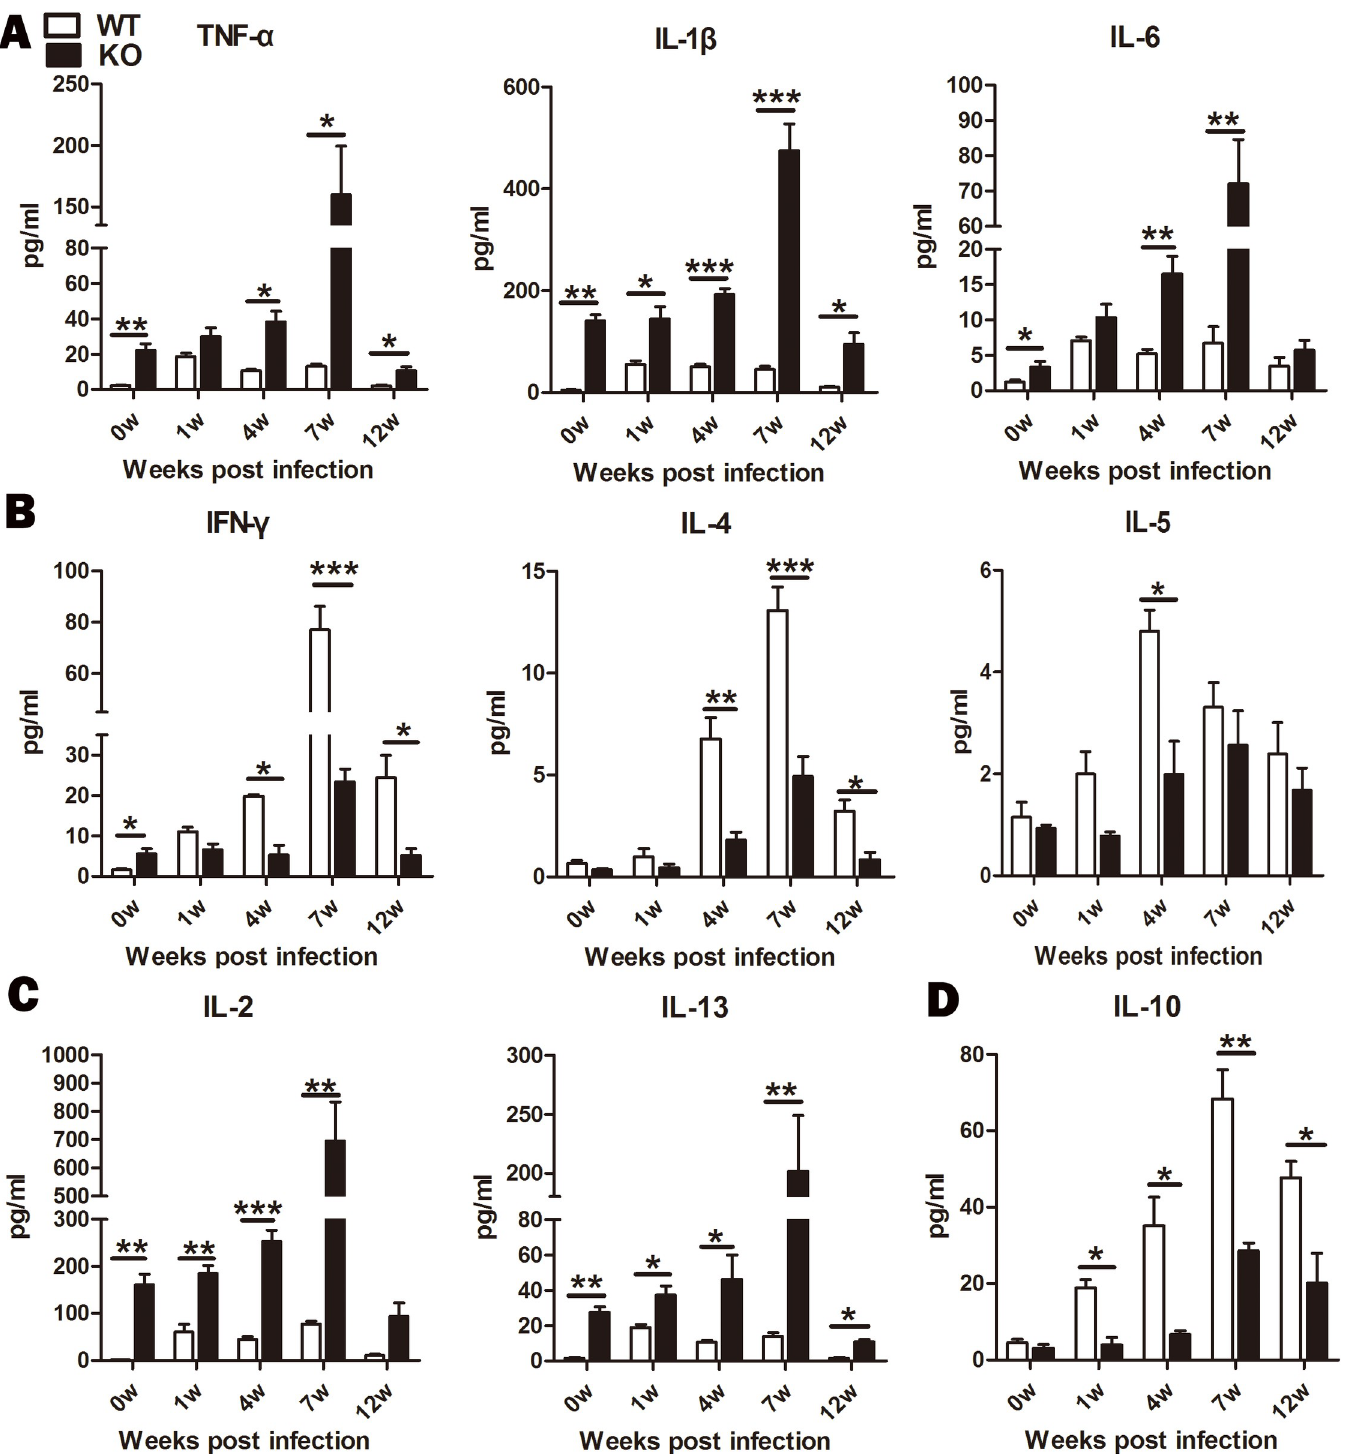
Fig 3. A pro-inflammatory and pro-fibrogenic cytokine profile developed in infected iNOS-KO rats. WT and KO rats were infected percutaneously with 200 S . japonicum cercariae and serum was obtained for cytokine expression analysis by Multiplex at 0, 1, 4, 7, and 12-weeks post-infection. (A) Pro-inflammatory cytokines TNF- α , IL-1 β , and IL-6 were significantly elevated in infected KO rats. (B) Th1 and Th2 cytokines were down-regulated in infected KO rats. (C) IL-2 and IL-13 were significantly up-regulated in infected KO rats. (D) The immunosuppressive cytokine IL-10 was significantly down-regulated in infected KO rats. n = 5 rats per group. Data shown are mean ± SEM and repeated twice with similar results. Significant differences have been noted, � P < 0.05, �� P < 0.01, ��� P < 0.001.